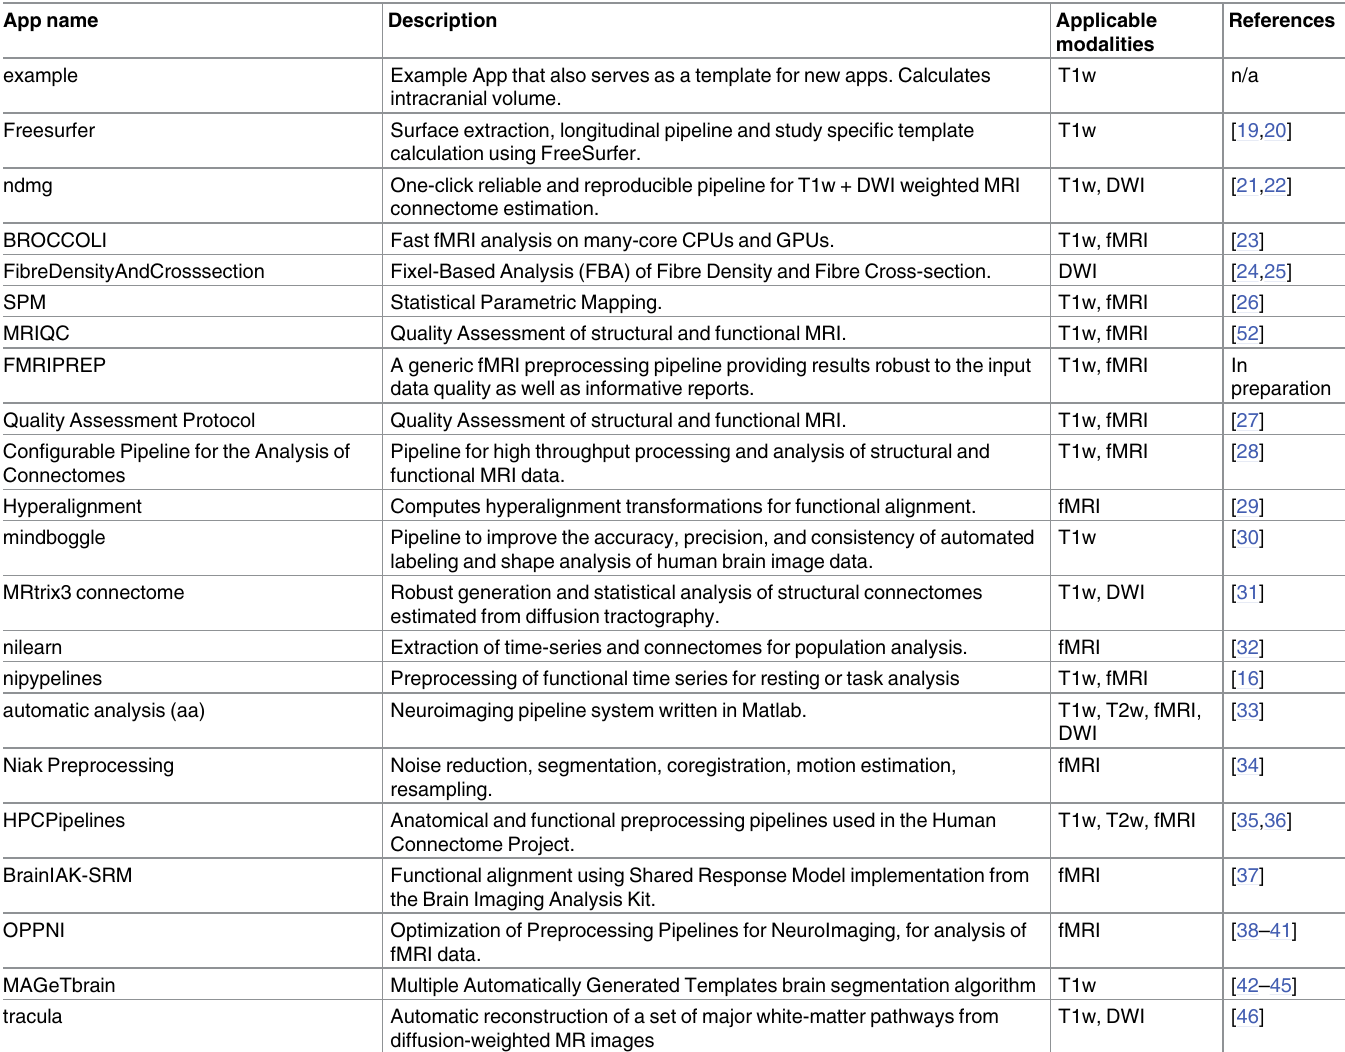
Table 1. List of currently available BIDS